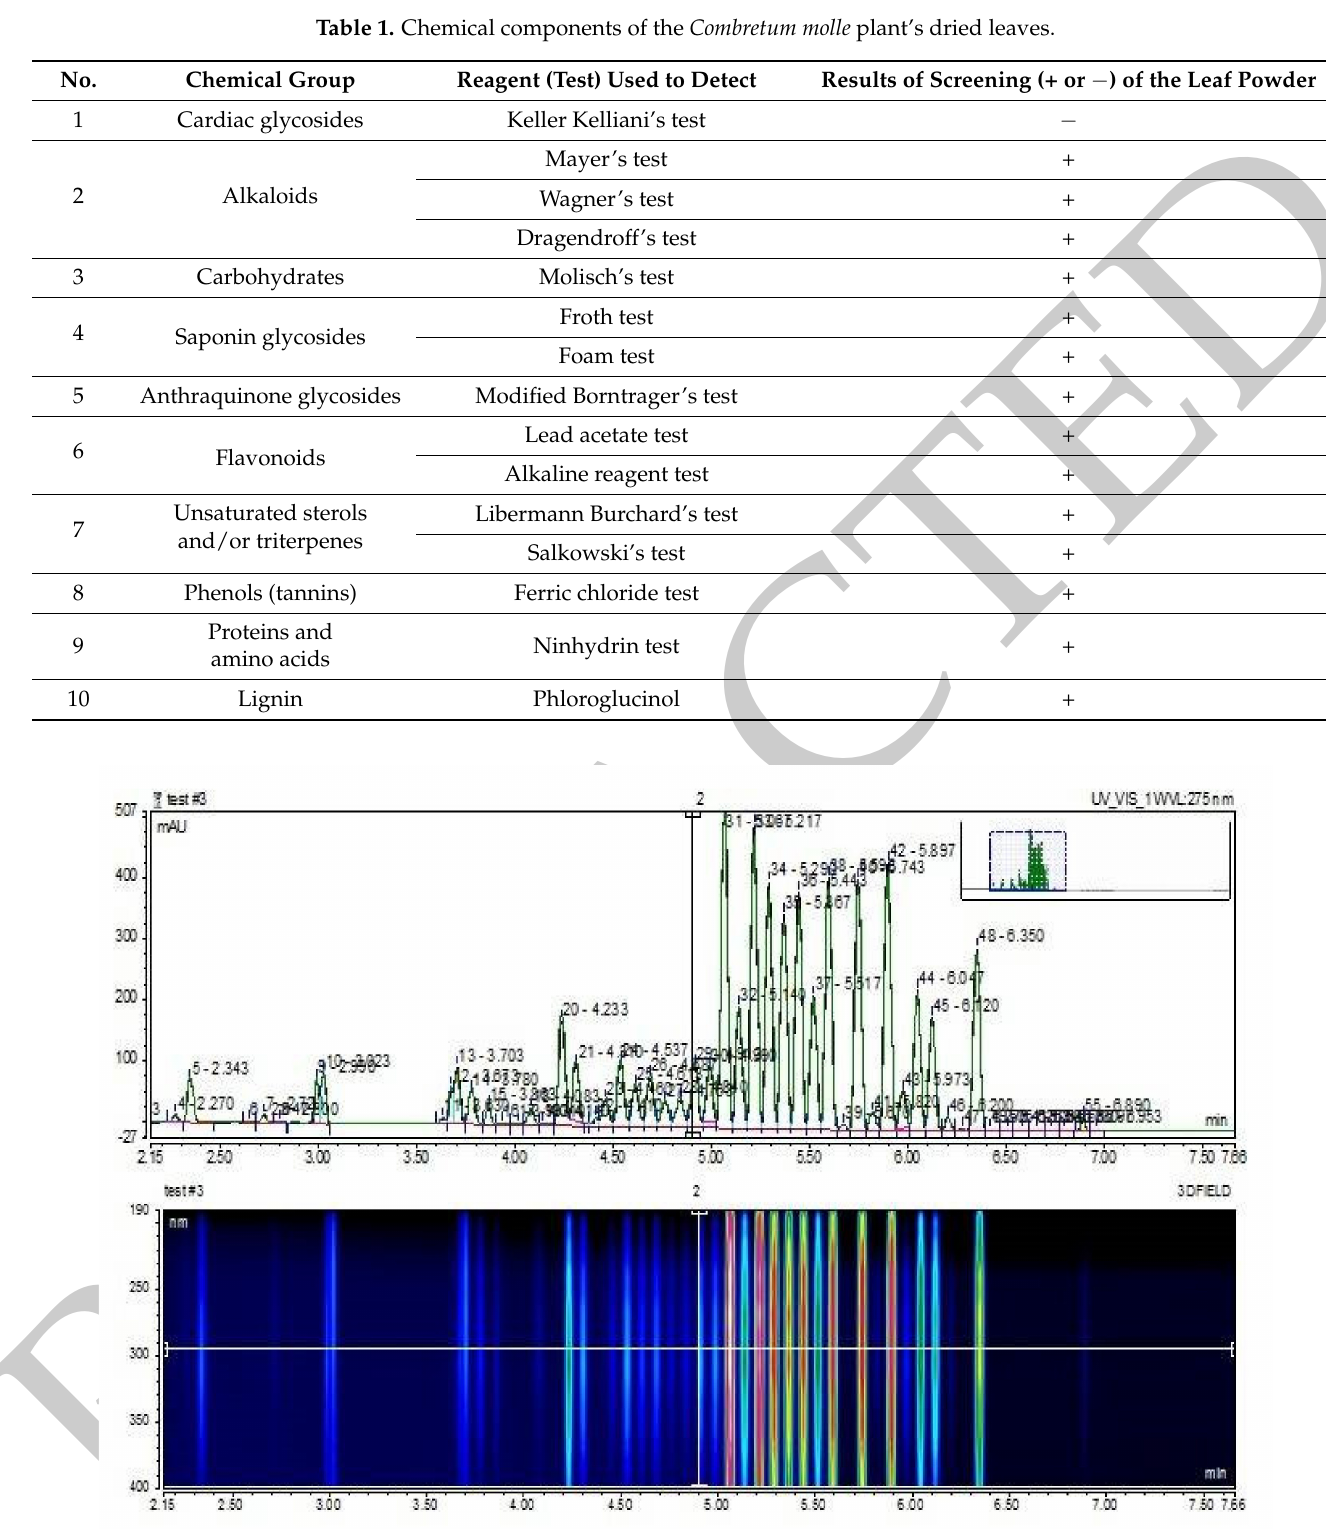
Figure 2. UHPLC and UV charts of the C. molle